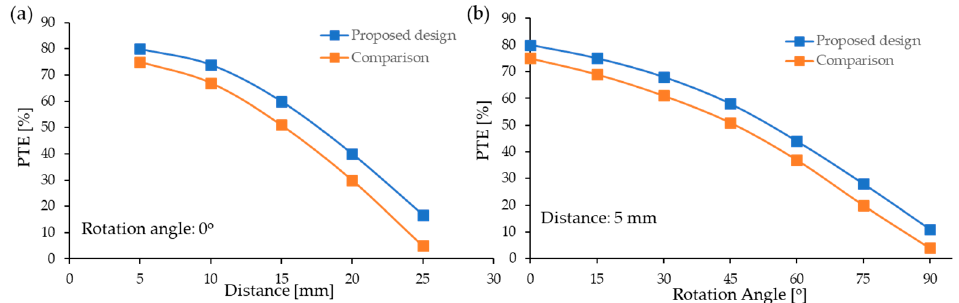
Figure 7. PTE calculated versus ( a ) transfer distance and ( b ) rotation angle in the simulation.